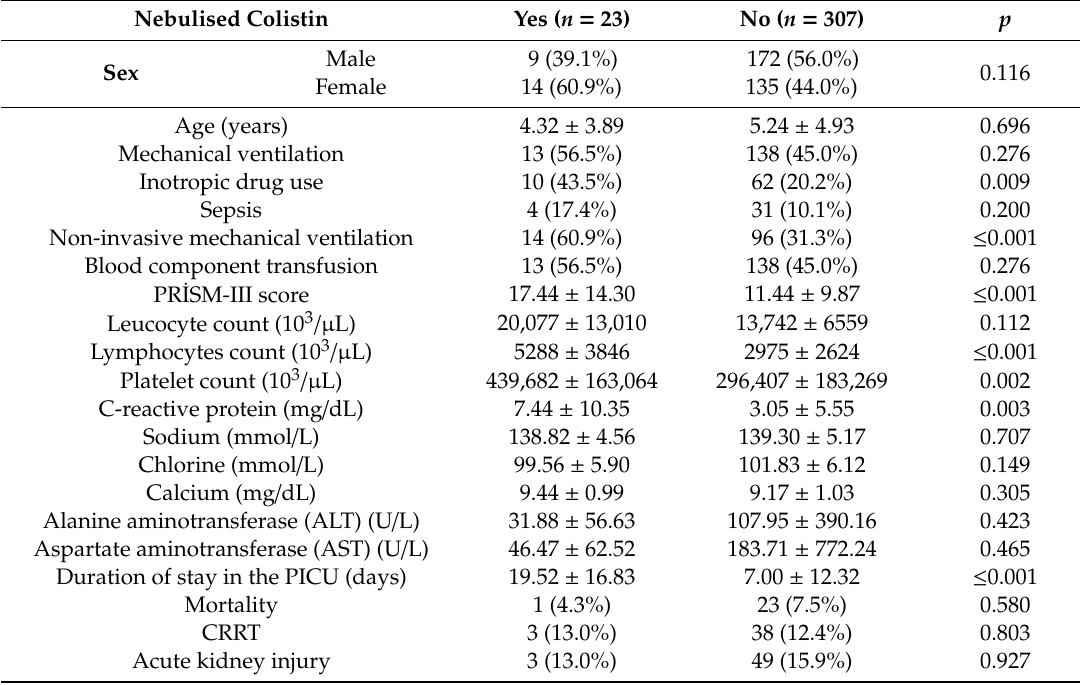
Table 2. Analysis of factors associated with adverse outcomes in patients with and without nebulised colistin